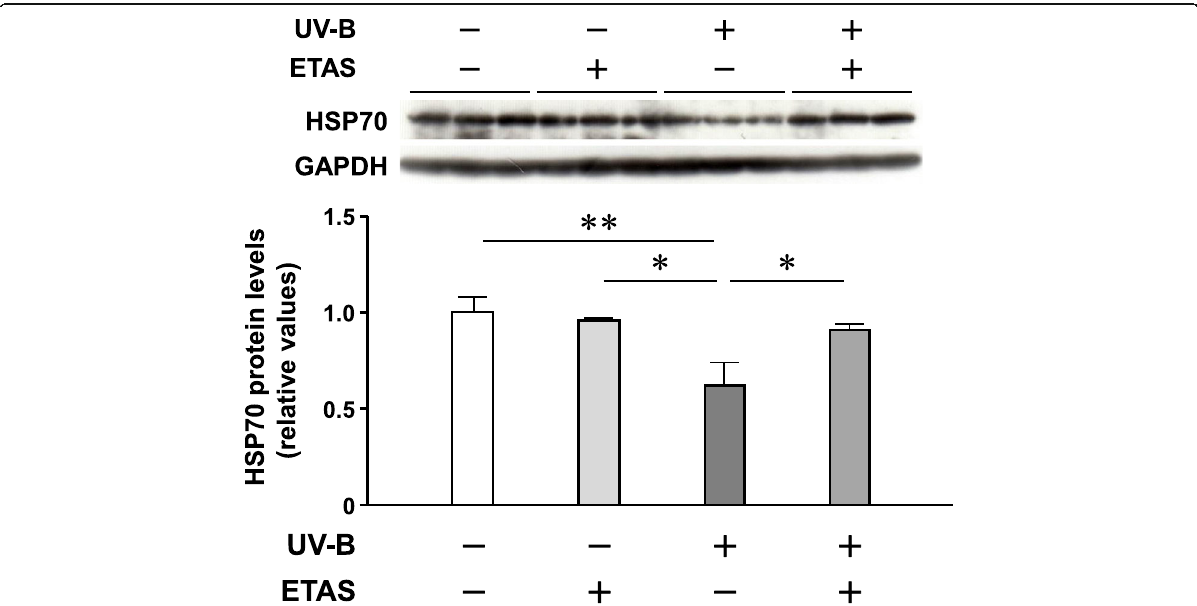
Fig. 2 Effect of EAS pretreatment on the UV-B irradiation-induced reduction in HSP70 protein levels in NHDFs. The cells were treated with EAS or dextrin for 24 h; immediately after UV-B irradiation, the cells were further cultured in supplemented medium for 6 h. The relative ratios of HSP70 with respect to GAPDH are shown. Mean ± SEM ( n = 3). * p < 0.05; ** p < 0.01 (one-way ANOVA and Tukey ’ s